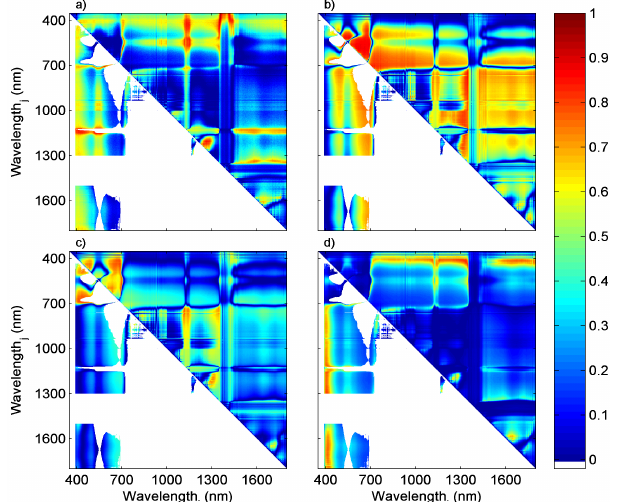
Figure 6. Coefficient of determination ( R 2 ) between normalised difference spectral index (NDSI) and (a) dry weight biomass ( n = 12; gm − 2 ), (b) gross primary productivity (GPP) ( n = 285; gCday − 1 ), (c) light use efficiency (LUE) ( n = 272; gCMJ − 1 ), and (d) fraction of photosynthetically active radiation absorbed by the vegetation (FAPAR) ( n = 369). The upper right half of each chart shows the unfiltered R 2 values, whereas the lower left half shows filtered R 2 , based on the filtering criteria described in Sect. 2.6.